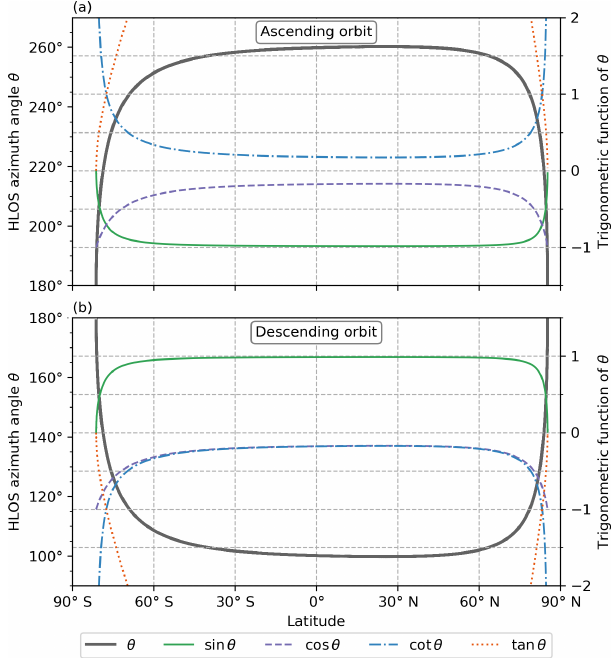
Figure 3. Aeolus azimuth angle and its trigonometric functions with respect to latitude for ascending (a) and descending (b)